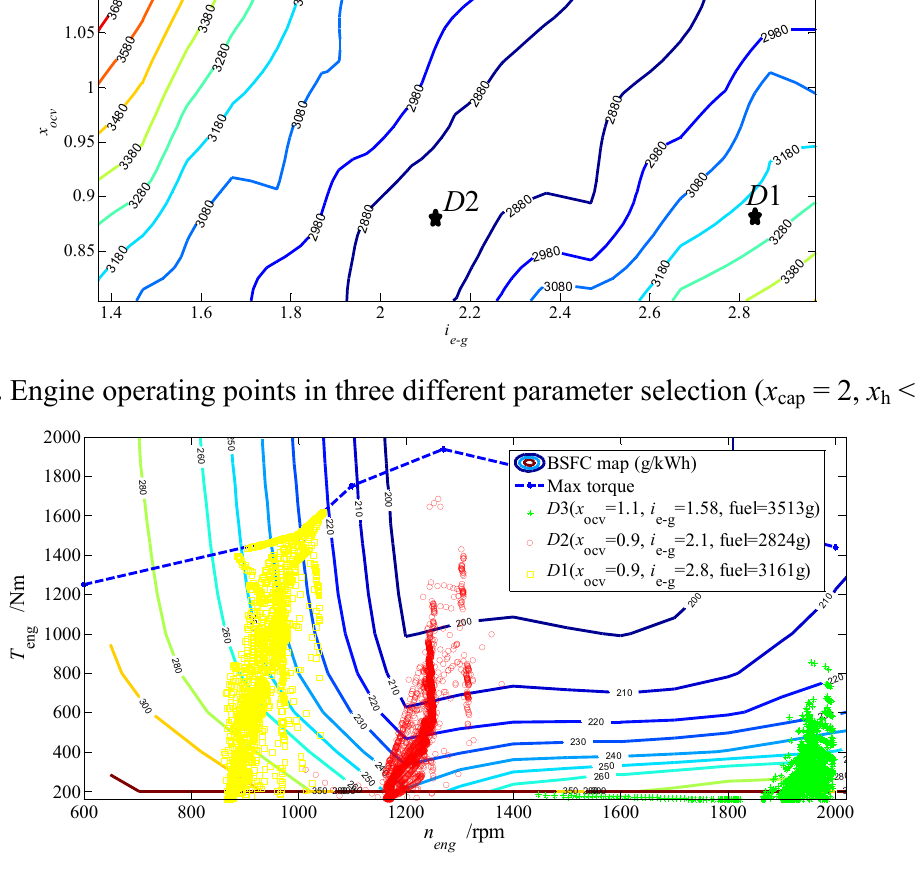
Figure 7. The fuel consumption contour (grams) vs . i